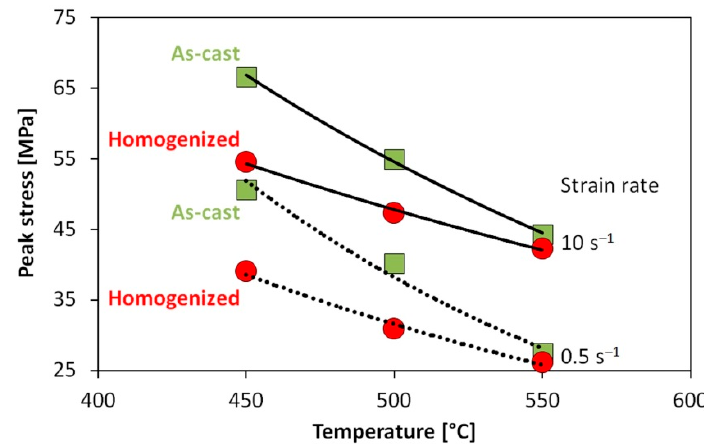
Figure 9. Effect of the true strain on the Q value of the homogenized 6082 alloy, according to Reference [45].